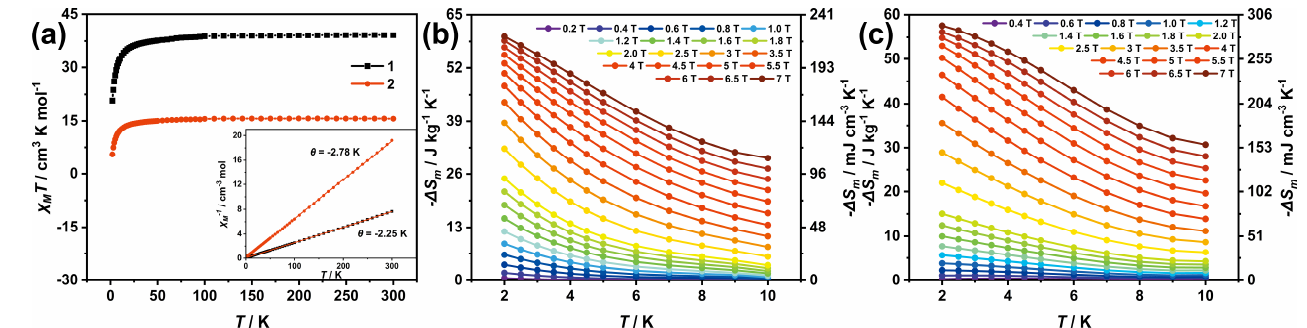
Figure 3. ( a ) Temperature dependence of χ M T for 1 and 2 under a 1000 Oe magnetic field in the range of 2−300 K; inset: the χ M‒1 vs. T plot of 1 and 2 in the temperature range of 2−300 K. The red solid lines are the best-fit, according to the Curie−Weiss law; experimental −Δ S m values of 1 and 2 for multiple temperatures and magnetic fields calculated from magnetization data: 1 ( b ); 2 ( c ).